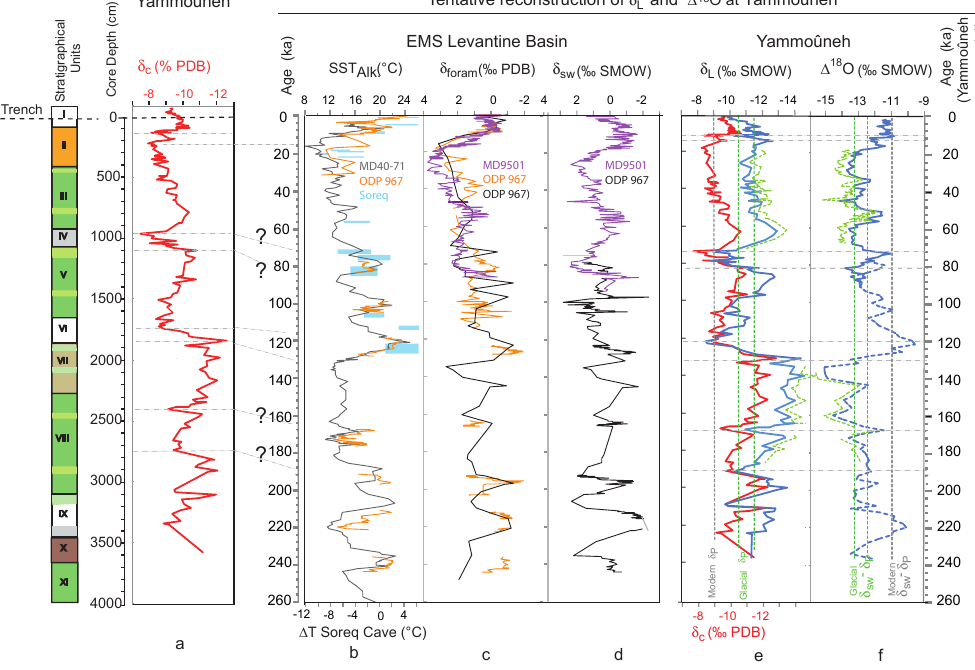
Fig. 7. Carbonate oxygen isotope record. Tentative reconstruction of δ L and 1δ 18 O= δ sw − δ L using EMS marine data. (a) The Yammoˆuneh δ c profile versus depth (values above 0cm of core depth come from trench TR02 which includes the entire Holocene period). (b) SST alk records from cores M40-71 and ODP 967 (Emeis et al., 2003), and inland temperature inferred from Soreq Cave speleothems (McGarry et al., 2004). (c) δ 18 O records of planktonic foraminifera ( δ foram ) from cores MD9501 (Almogi-Labin et al., 2009) and ODP 967 (Kroon et al., 1998: black; Emeis et al., 2003: orange). (d) Isotopic composition of sea surface water ( δ sw ) in the Levantine basin calculated from SSTs in core MD40-71 and δ foram from cores MD9501 (0–86ka) and ODP 967 (78–250ka, combined Kroon et al., 1998 and Emeis et al., 2003, data). (e) The Yammoˆuneh δ c profile and reconstructed δ L versus time (according to our age model). The blue δ L curve is based on inferred 1T sealevel on the modern mean annual temperature difference between sea level and Yammoˆuneh, the green one accounts for an additional altitudinal cooling during glacial periods. Vertical dashed lines: modern and inferred glacial δ P values. (f) Calculated 1δ 18 O. Colours as for (e) . Dashed and full blue curves are based on δ sw derived from cores ODP 967 and MD9501, respectively. Vertical dashed lines: δ sw − δ P values inferred for modern and glacial times. See text for